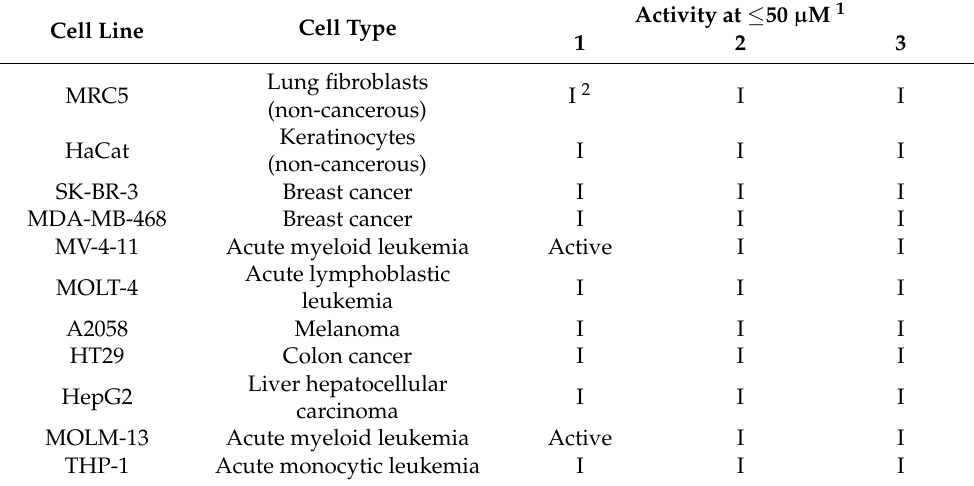
Table 3. Screening of cytotoxic effect of compound 1 – 3